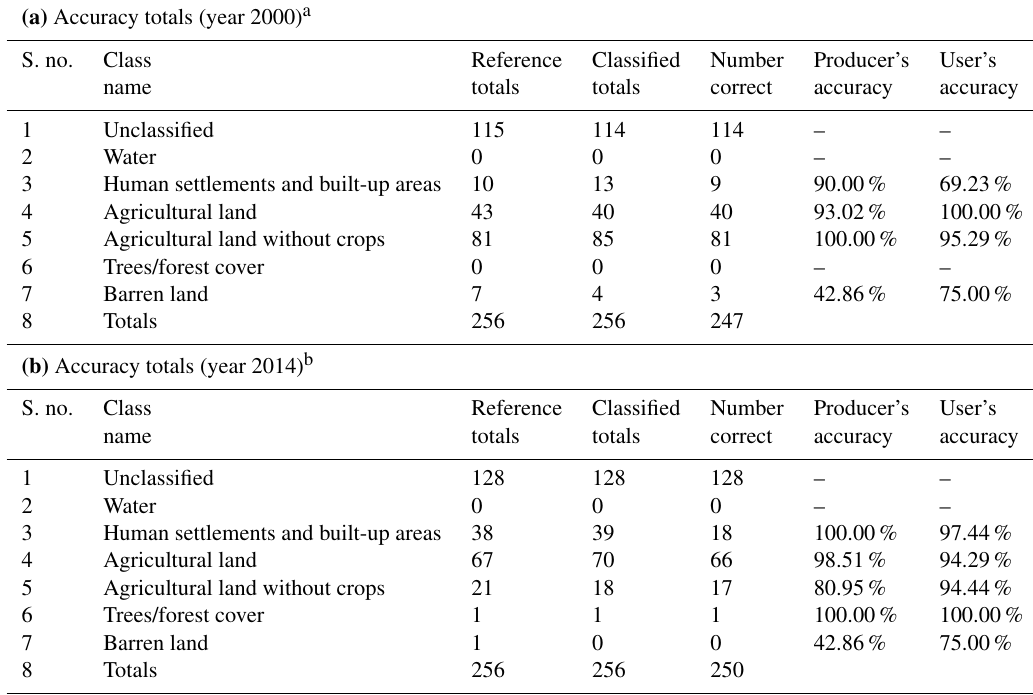
Table 3. Accuracy assessment